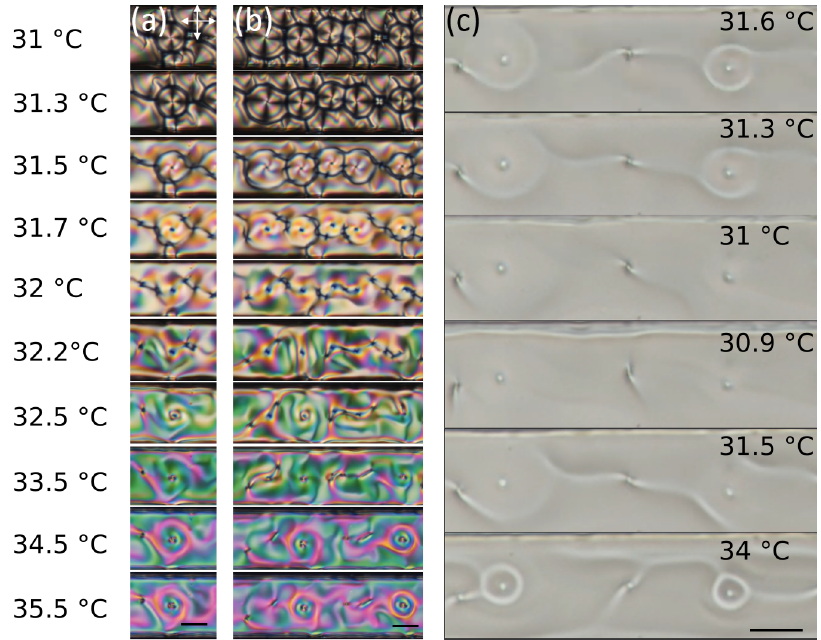
Figure 4. Memory at the smectic-cholesteric transition. ( a , b ) Two sequences of images from details of the supplementary video V2 showing defects heated up from smectic to cholesteric, with temperature ranging from 31 to 35.5 ◦ C. It is possible to see how memory is retained at the phase transition. ( c ) Sequence of images from supplementary video V3 showing a circular cholesteric domain. The domain is cooled near the phase transition down to 30.9 ◦ C(it is possible to see the “unwinding” of the cholesteric helix) and then heated up again to 34 ◦ Cbefore it turns into smectic, retaining its defect structure. All scale bars are 20 µ